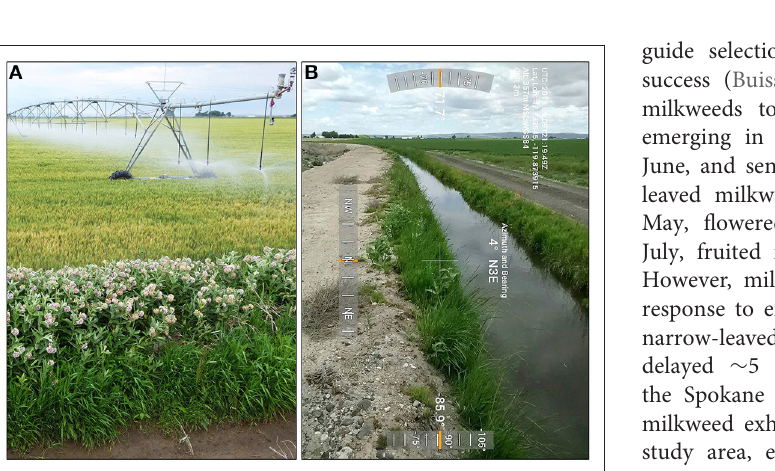
FIGURE 7 | Examples of “indirect watering” management actions: (A) showy milkweed at edge of pivot-irrigated grain field, Jefferson County, Idaho, 2016; (B) showy milkweed established in an irrigation canal, Grant County, Washington,